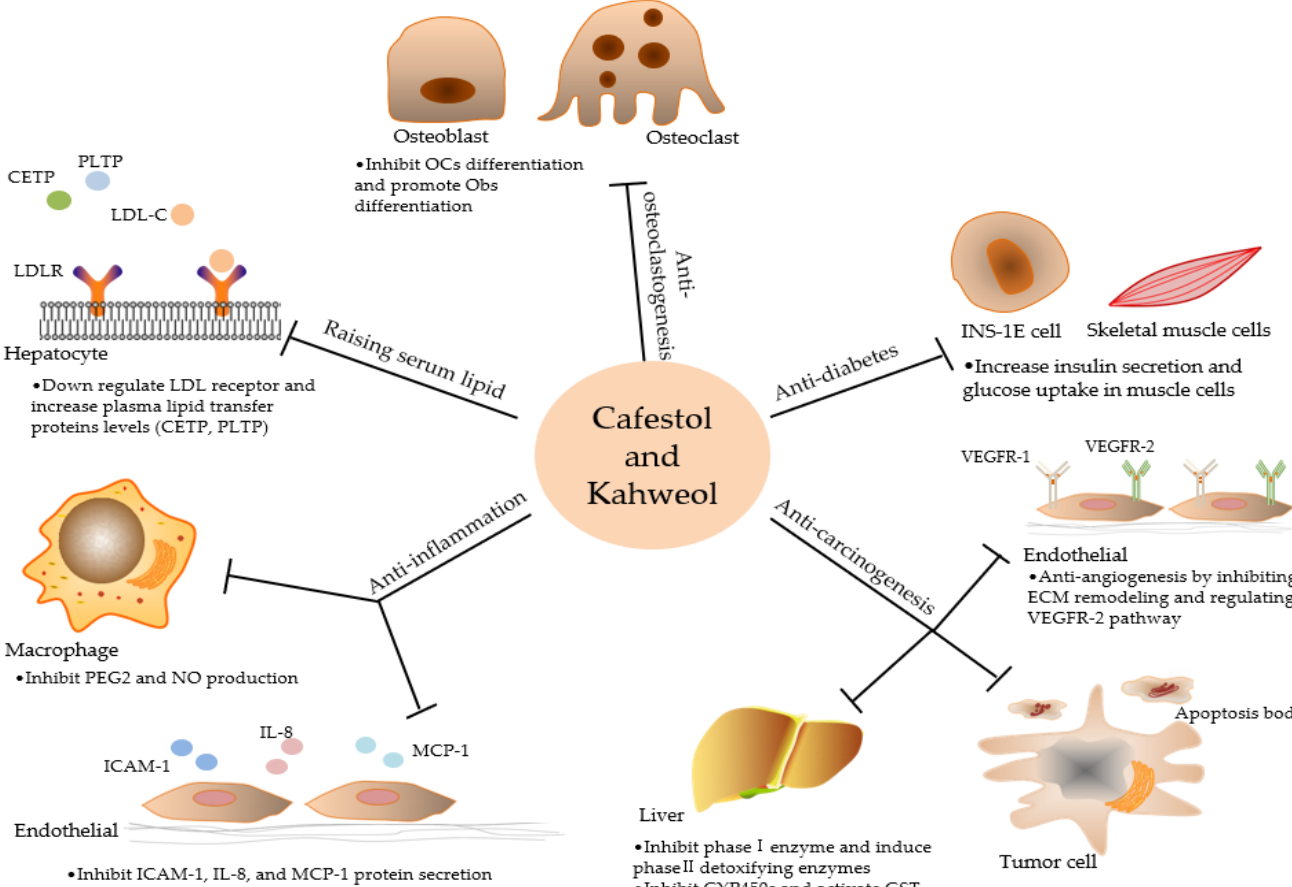
Figure 2. Diagram showing bioactivities and targets of cafestol and kahweol. Cafestol and kahweol raise human serum lipid level, and show extensive anti-inflammatory, anti-cancer and potential anti-diabetic